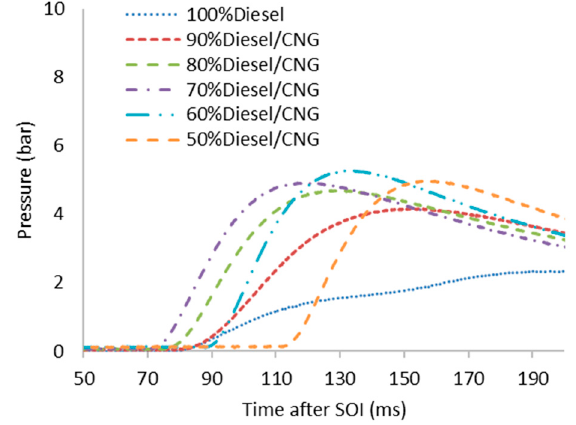
Figure 3. Pressure profile for various mixture compositions of d gap.